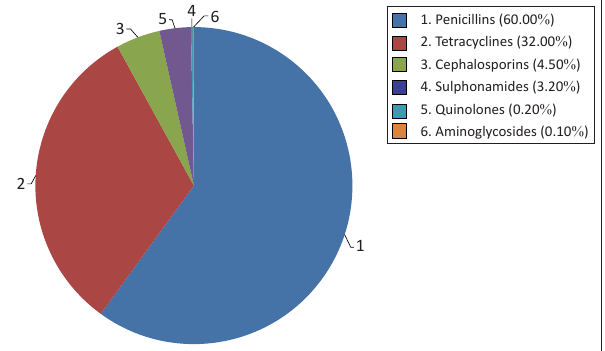
FIGURE 4: Percentages of volume (kg) of parenteral antimicrobials sold during 2002–2004.